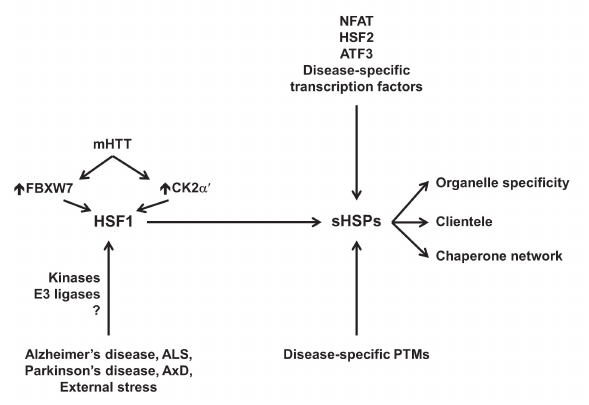
Figure 1: Multiple levels of regulation of small heat shock proteins in neurodegeneration. In Huntington disease mutant huntingtin protein (mHTT) increases the levels of CK2α¢ and FBXW7 leading to altered HSF1 protein levels. Future studies will reveal whether disease-specific molecular pathways or unfavorable external conditions affect the stability and function of HSF1. Also,